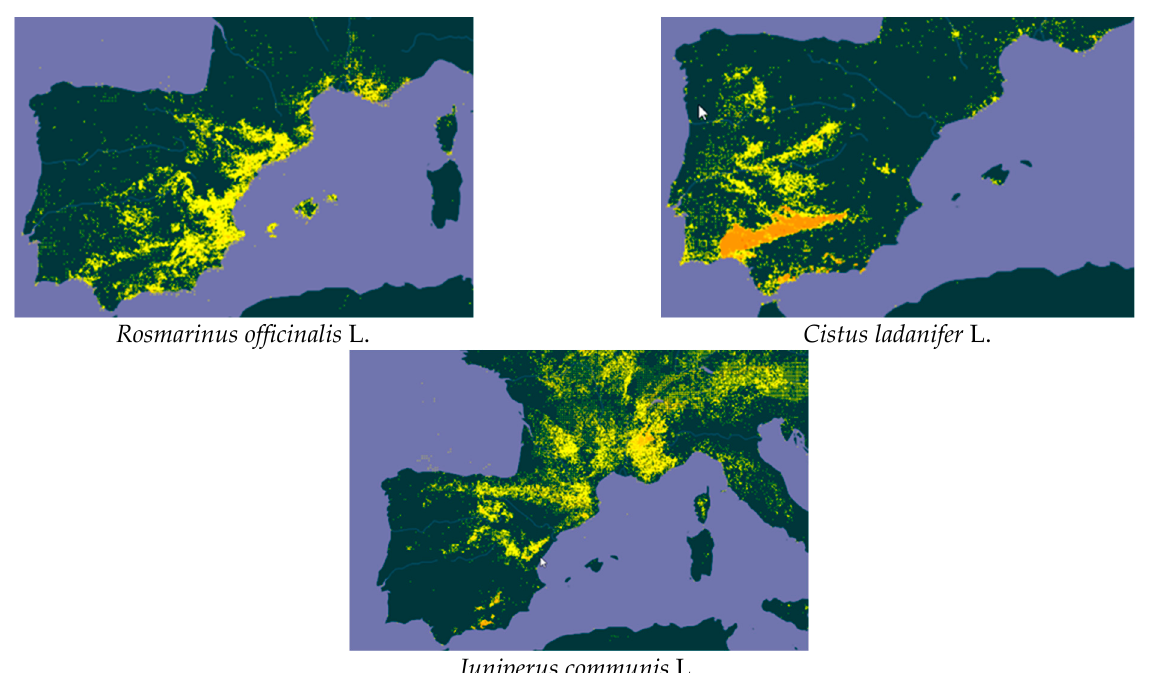
Figure 1. Distribution of the selected species in the Mediterranean area according to the Global Biodiversity Information Facility (GBIF) [12].